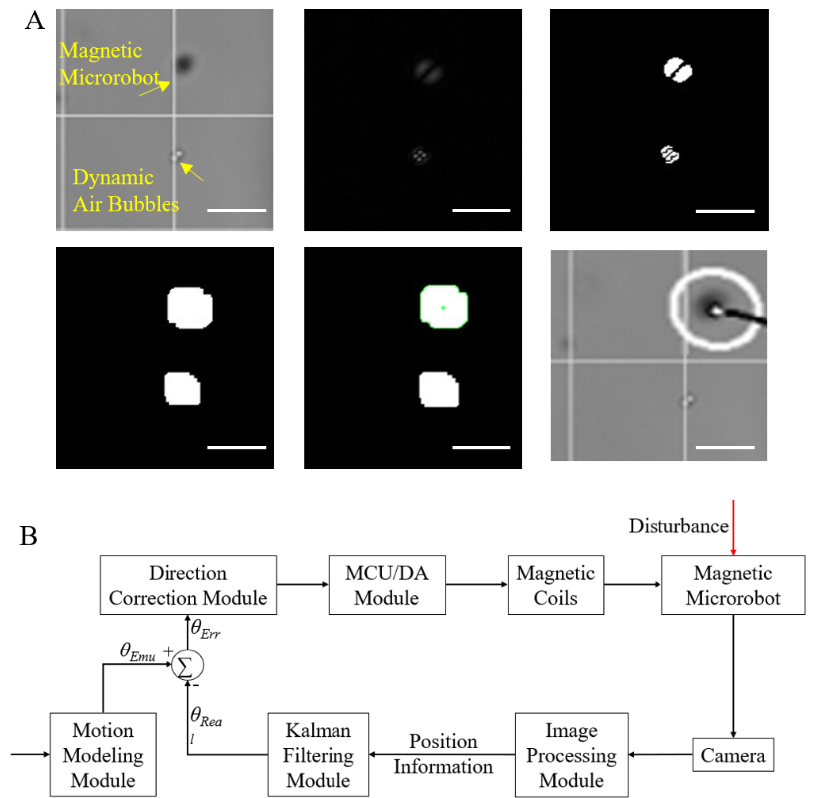
Figure 2. ( A ) Image processing technology, including real images, image difference, binarization, corrosion and expansion images, optimal fitting and contour detection, and reallocation labeling. ( B ) Block diagram of the vision-based closed-loop directional control module. Scale bars: 25 µ m.